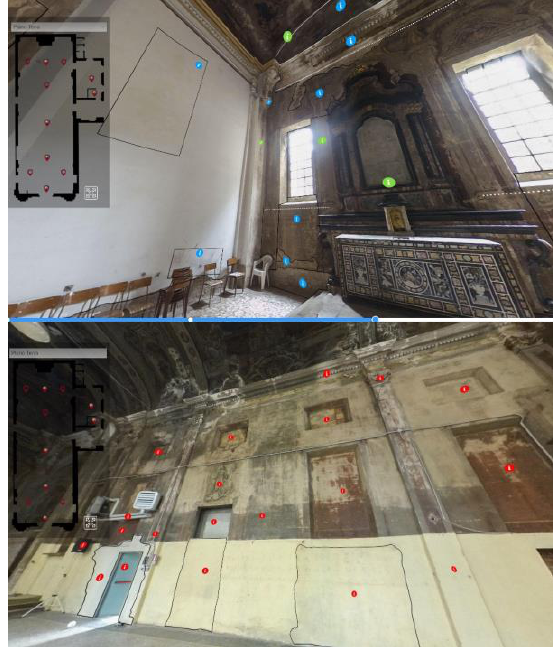
Figure 9. The spherical images in the Church with some icons to access additional information.